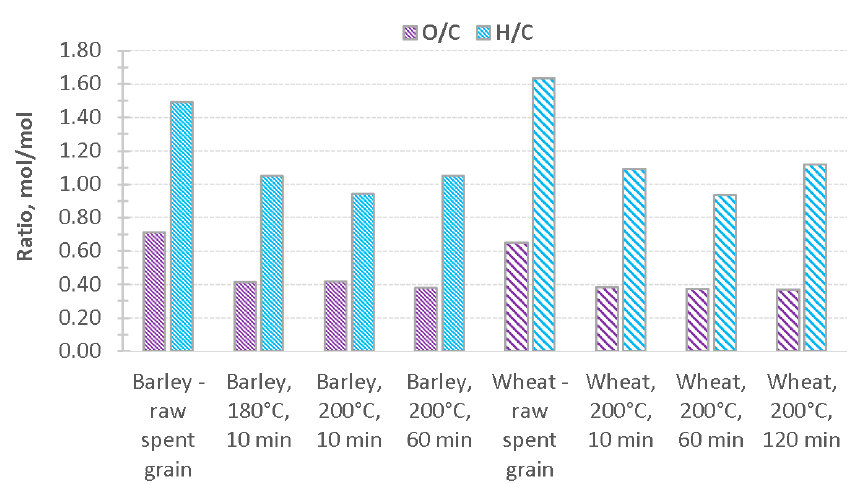
Figure 5. Molar ratios (O / C and H / C) for feedstocks and respective hydrochars.